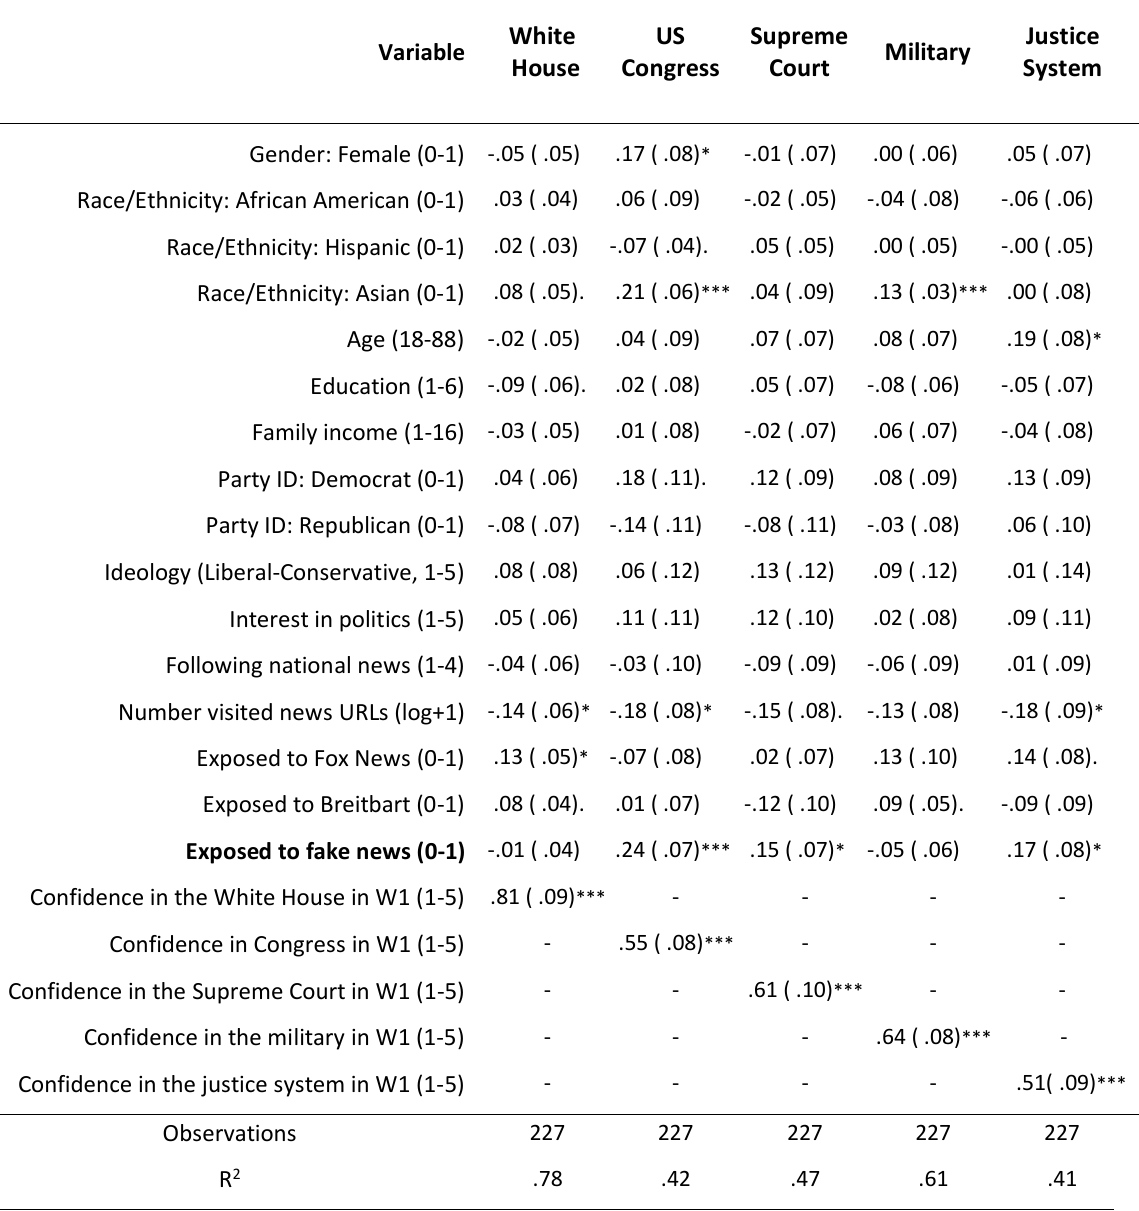
Table B3. Predictors of confidence in political institutions. The table includes standardized coefficients from ordinary least squares regressions with multiple imputation